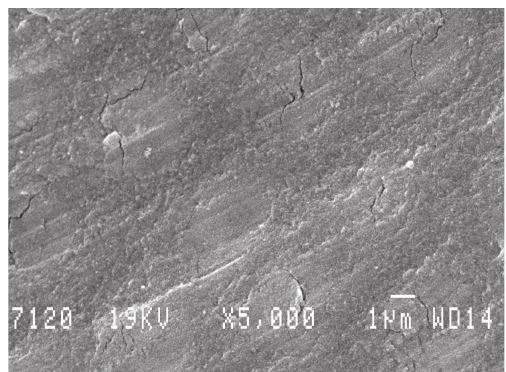
Figure 3: View of the dentine drilled without any complementary treatment exhibited a smear layer covering the tubules (group M). Magnification: 5000x. Scale bar = 1 µ m.